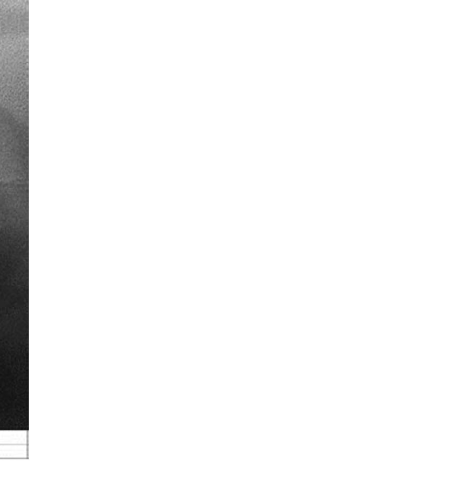
Figure 6. TEM image of acid functionalized